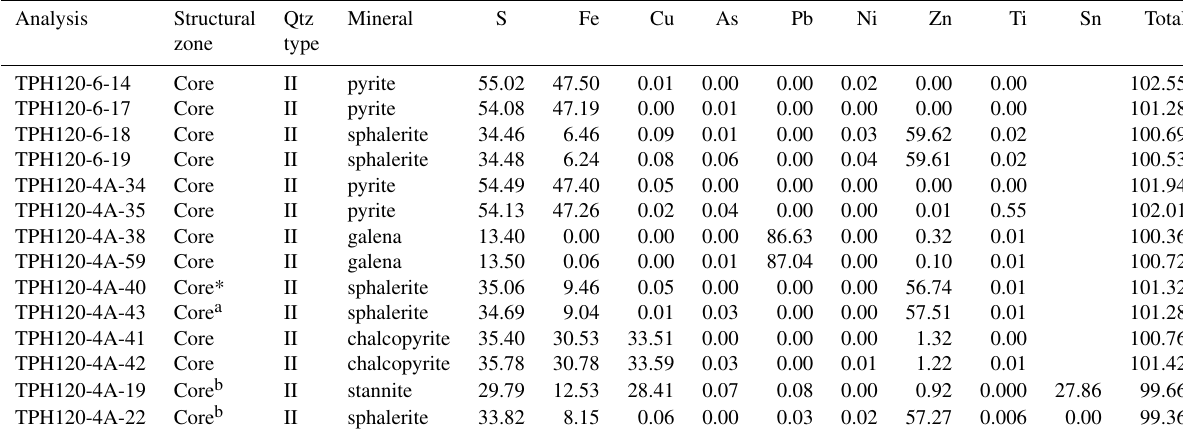
Figure 11. Chlorite chemical composition diagram and mineral pair geothermometry applied to the assemblages of the Qtz I and Qtz II veins. (a) Chlorite compositional diagram based on Hey (1954). Green, red, pink, and light blue symbols indicate distinct chlorite textures in association with Qtz I and Qtz II veins. (b) Chlorite–quartz formation temperature estimated using the method of Bourdelle and Cathe- lineau (2015). The maximum temperature is from the Qtz I chlorite pair from the fault core. (c) Estimated temperature of formation of sphalerite–stannite in association with the Qtz II vein (based on Shimizu and Shikazono, 1985). The region of the plot that was calibrated with this geothermometer lies between the 250 and 450 ◦ C isotherms. Table 3. Representative EPMA of sulfides associated with Qtz